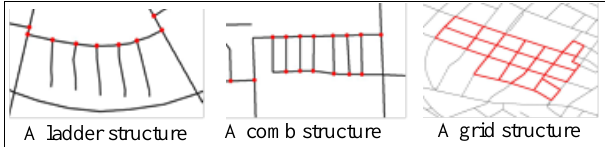
A ladder structure A grid Figure 10. Local road patterns (adapted from Heinzle et al. 2007)